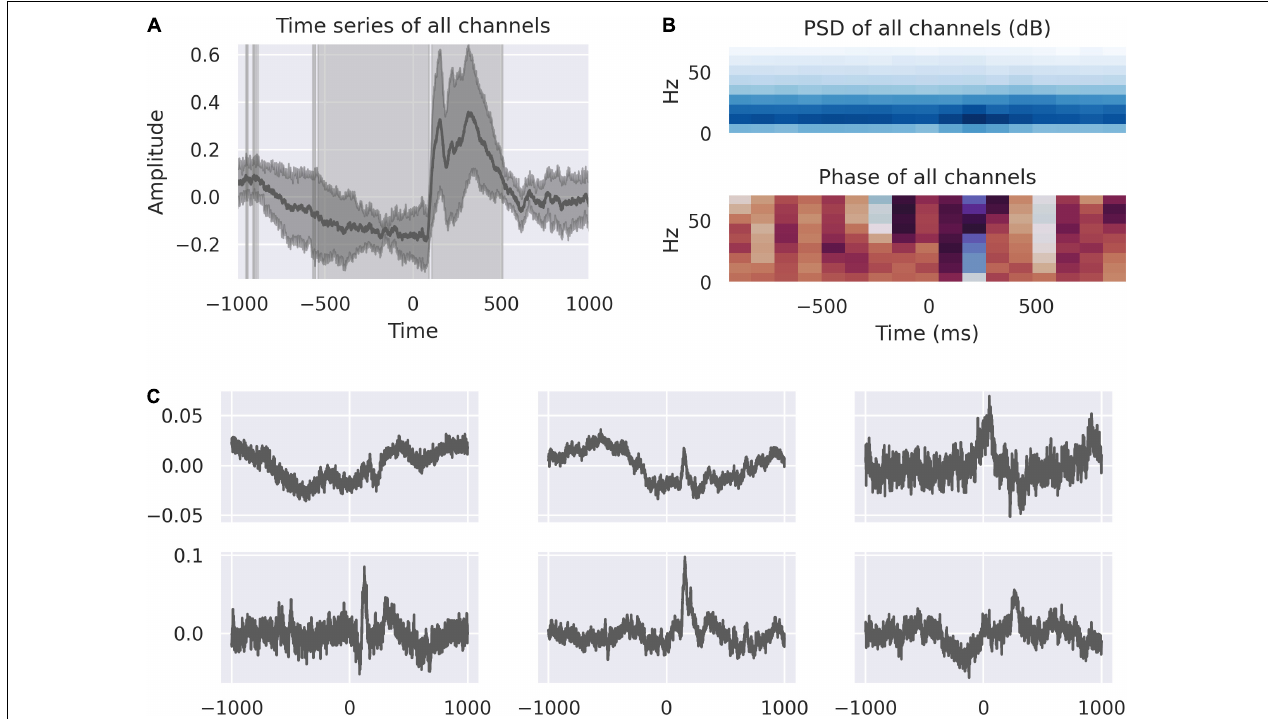
FIGURE 1 | The dACC responds to feedback. (A) The average feedback-locked response across all channels; shading represents the variance between electrodes. The highlighted regions demonstrate where the response is statistically significant at p < 0.0001, Bonferroni corrected. This identifies a movement correlated and anticipatory window beginning at 528 ms before feedback and a response window from +100 ms to +500 ms post-feedback. (B) Power spectral density and phase spectrum across all channels, time-locked to feedback. The time-domain response is associated with activity in the 10–20 Hz range. The pre-feedback window is marked by a phase reset at roughly –200 ms, corresponding with a reduction in variance in the average signal. (C) Source decomposition of all channels, representing the activity of statistically independent populations. The activity of these populations correspond to the components of the overall signal, including pre-feedback and early and late post-feedback